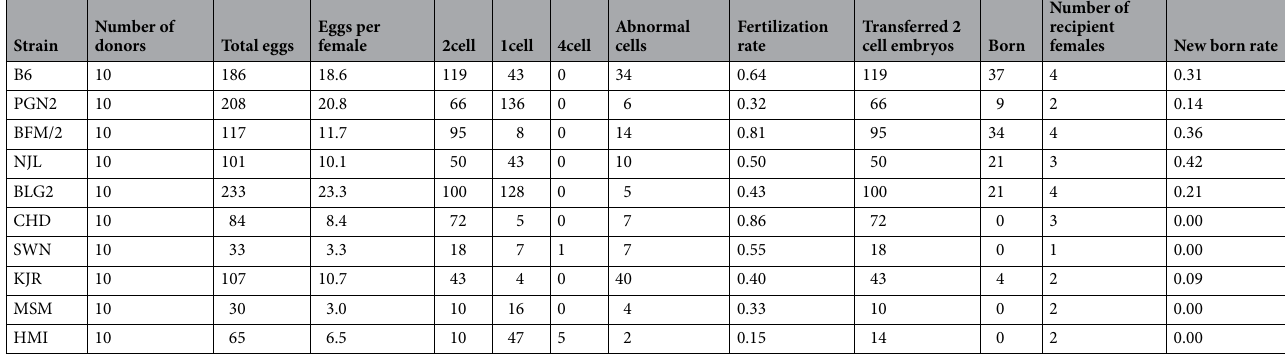
Table 2. Comparison of efficiencies of IVF experiments between wild and laboratory